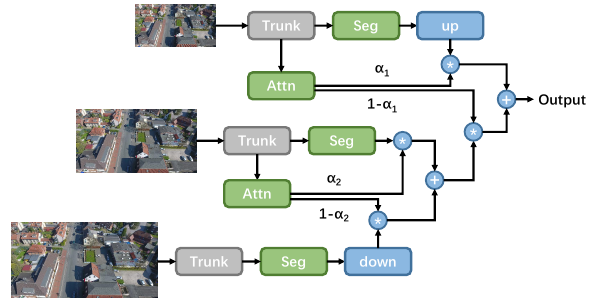
Figure 3. Architecture of the hierarchical multi-scale attention networks. In addition to the predicted score maps, extra weighting masks are predicted from the attention sub-networks for fusing the score maps of adjacent scales. ⊕ , (cid:126) stand for element-wise addition and multiplication, respectively.